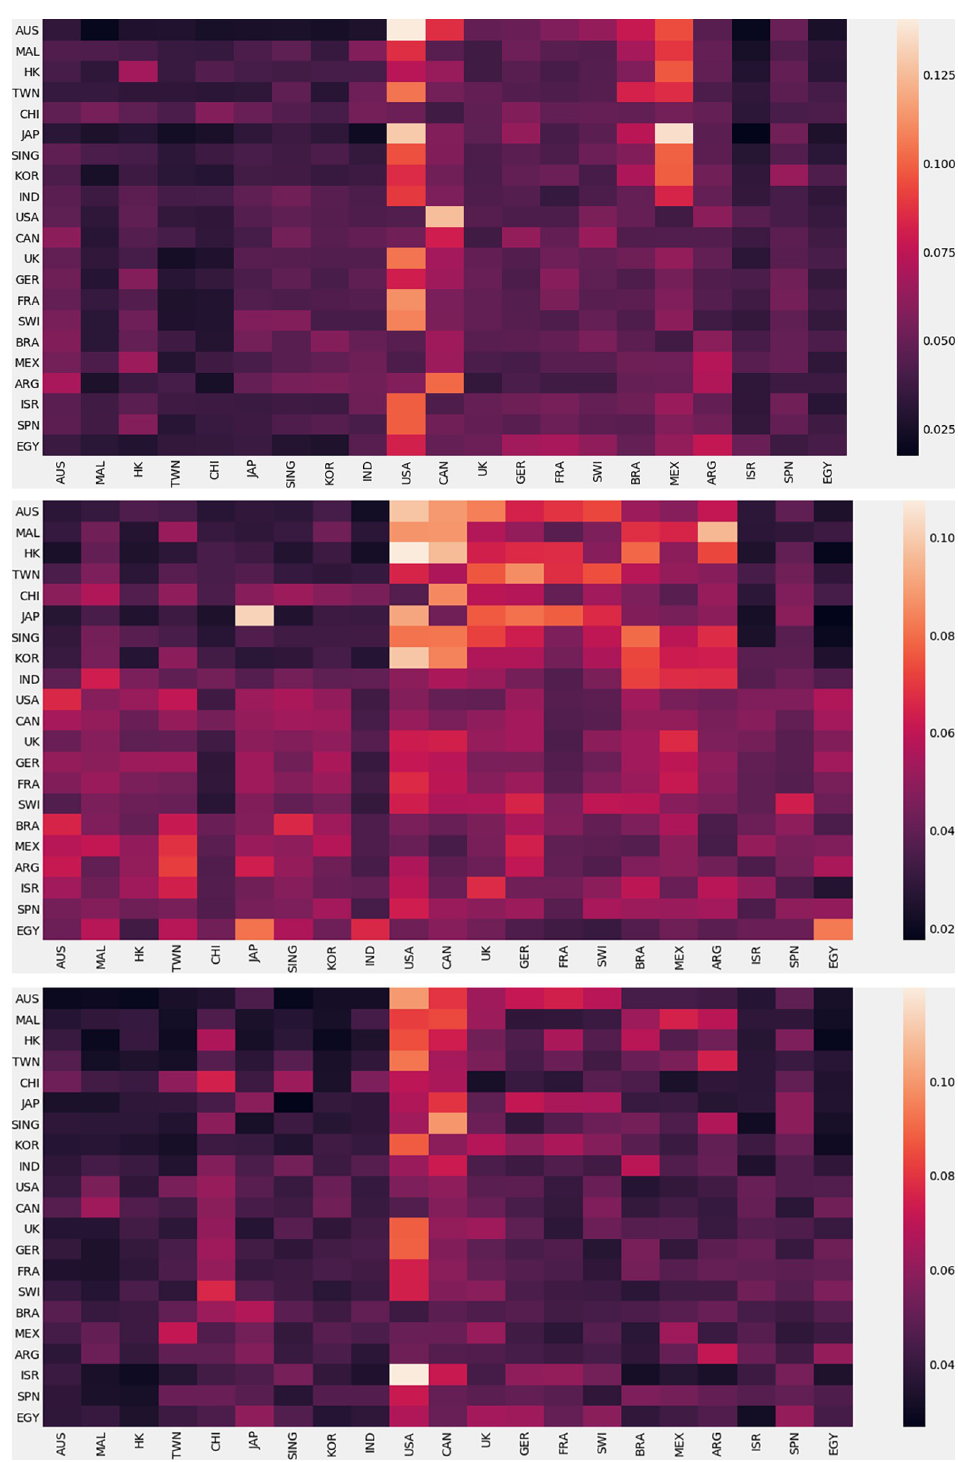
Fig 1. The feature ranking matrices for 21 global indices. (a) during the global crisis (2008), (b) during the ESD crisis (2011), (c) during the period of the global decline in the value of stock prices (2016). Lighter color indicates higher influence and darker color specifies the